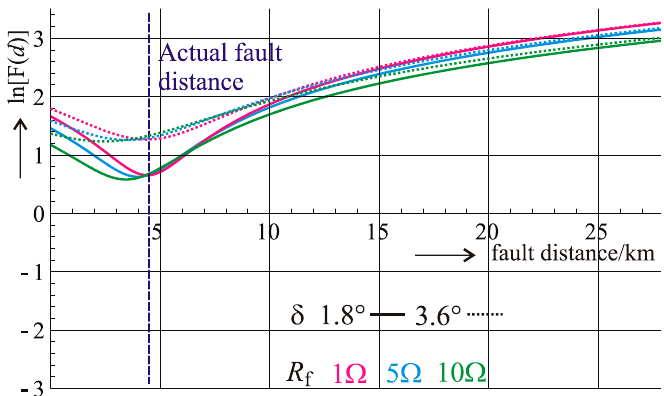
Figure 12. Algorithm outputs comparison for various fault resistances and synchronization angles.